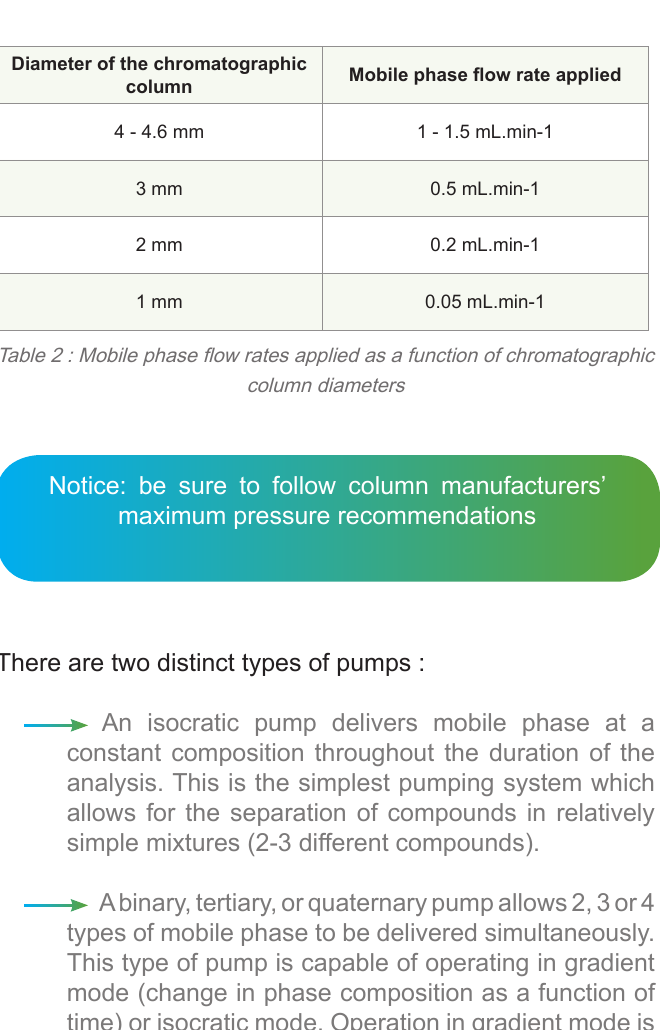
applied, based on the characteristics of the chromatographic columns used.